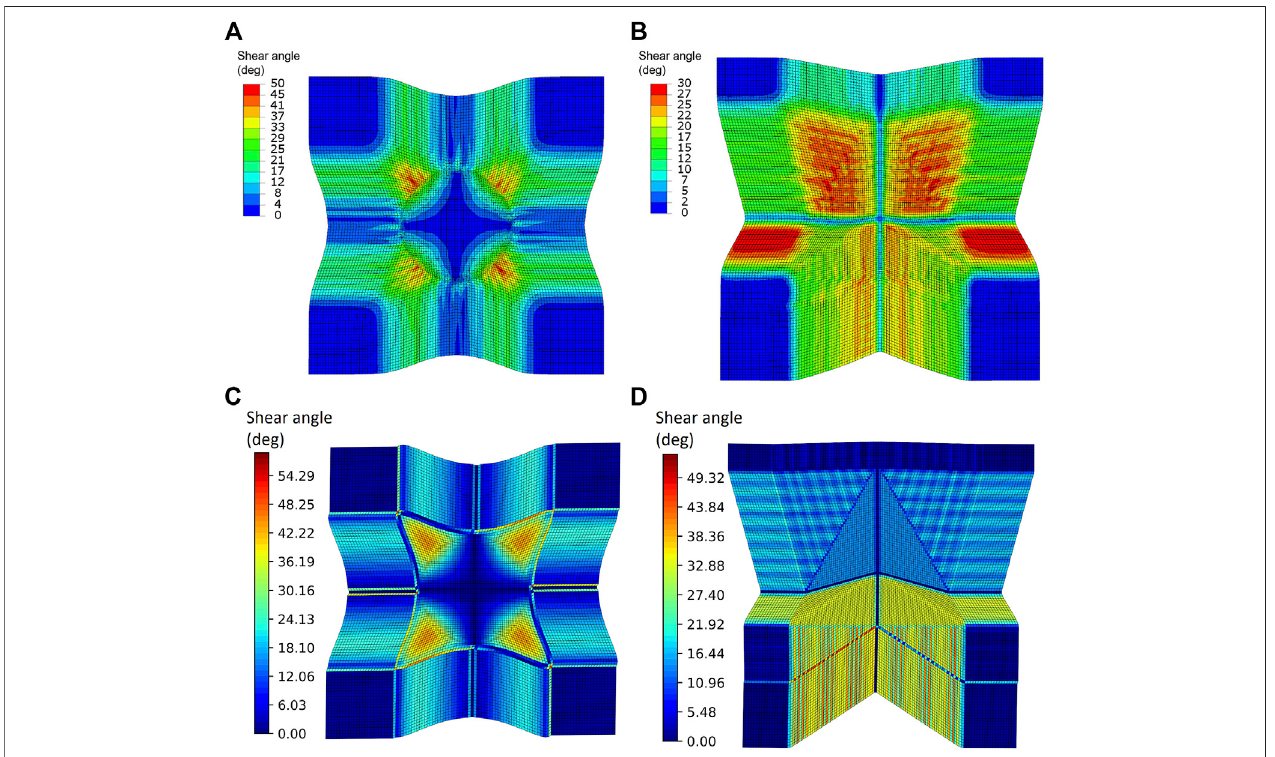
FIGURE9| Shearanglecontourplotfrom (A) theHypoDrapemodelinhemisphericforming; (B) tetrehedronforming; (C) theshearangleofthekinematicdrapingin hemispheric forming and (D) the shear angle of the kinematic draping in tetrahedron forming.